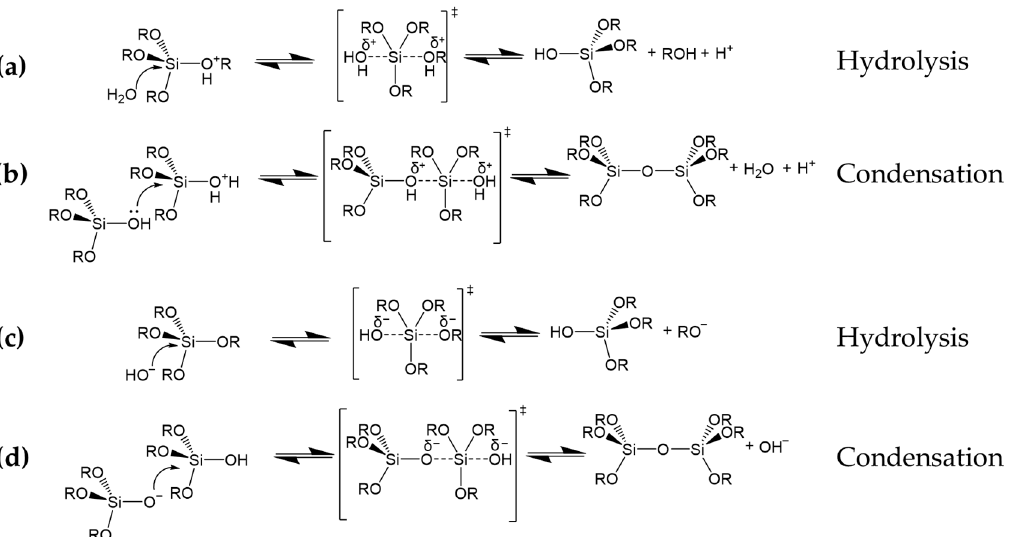
Figure 2. Hydrolysis and condensation reaction steps of silane alkoxide precursors occurring in acidic ( a , b ) and alkaline environments ( c , d ). Reproduced from MDPI Ref. [31].